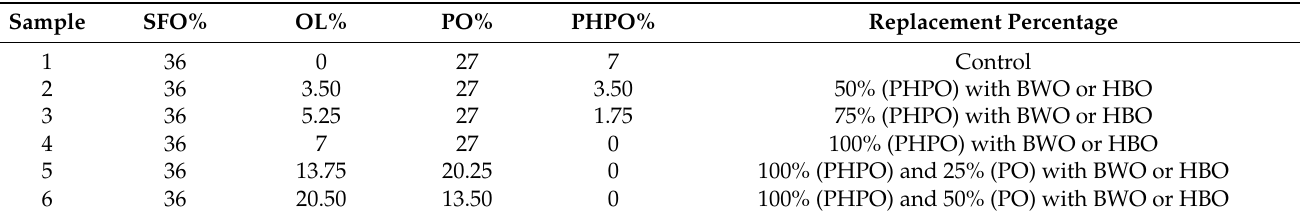
Table 1. Formulation of margarine samples (70 %wt fat) prepared with beeswax oleogel (BWO) and hydrocolloid-based oleogel